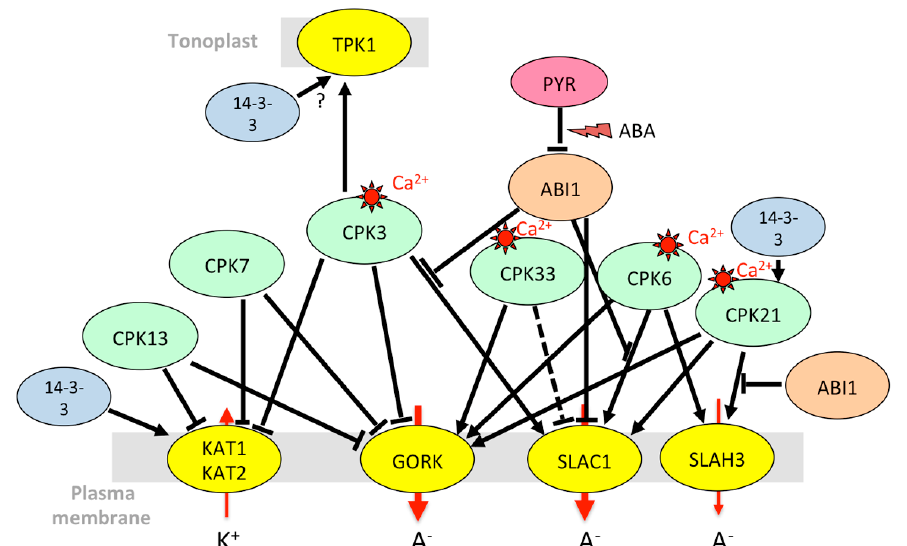
Figure 4. Model for integrated regulation of Shaker and anion channels by CPKs (calcium-dependent protein kinases) in Arabidopsis guard cells. The dotted T-bar indicates that the effect might be indirect, and the symbol “?” that the activation of TPK1 by 14-3-3 proteins was not studied in guard cells. See Figure 1 for details of the legend. References: 14-3-3 to CPK21 [171]; 14-3-3 to TPK1 [184], 14-3-3 to KAT1/KAT2 [202], ABI1 to CPK3-SLAC1 and CPK6-SLAC1 [141]; ABI1 to CPK21-SLAH3 [78]; ABI1 to SLAC1 [167]; CPK3 to TPK1 [72], CPK13 to KAT1/KAT2 [163,170], CPK13 to GORK [163]; CPK3 and CPK7 to KAT1/KAT2 and GORK [163]; CPK6 and CPK33 to GORK [163]; CPK21 to GORK [171]; CPK3 to SLAC1 [168]. CPK6 to SLAC1 [139,167,168]; CPK33 to SLAC1 [173]; CPK6 to SLAH3 [141]; CPK21 to SLAC1 [139]; CPK21 to SLAH3 [78]; CPK33 to SLAC1 [173];